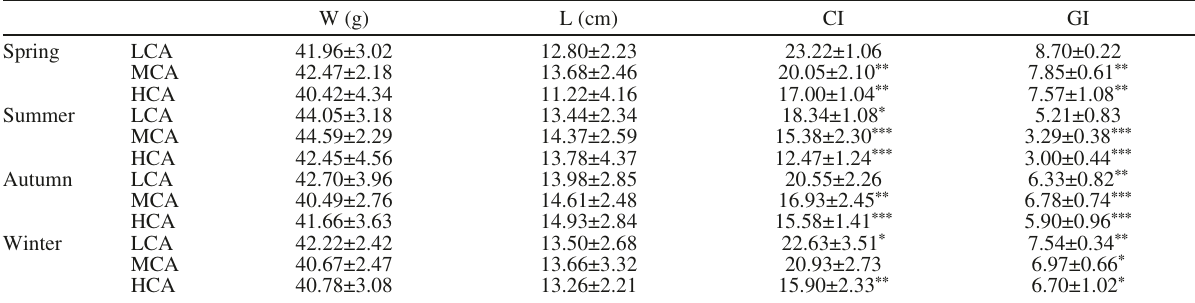
Table S2. – Mean (±SD) weight (W), length (L), condition (CI) and gonad (GI) indices of R. decussatus from Tunisian lagoons: Ghar el Melh (LCA), the North Lake (MCA) and the South Lake (HCA). Values are expressed as means ±SD (n=40 replications). Significant differences are determined at 0.05 using two-way ANOVA: *p<0.05, **p<0.01; ***p<0.001. W (g) L (cm) CI GI